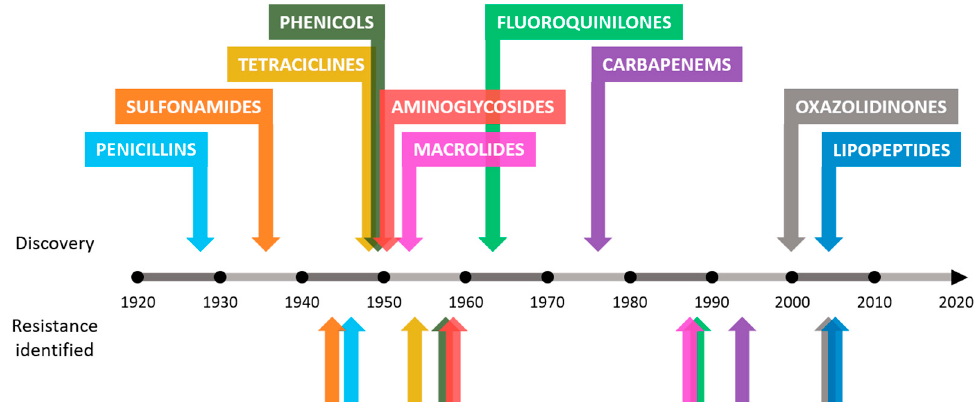
Figure 2. Approximate dates of discovery of new classes of antibiotics and identification of bacterial resistance.